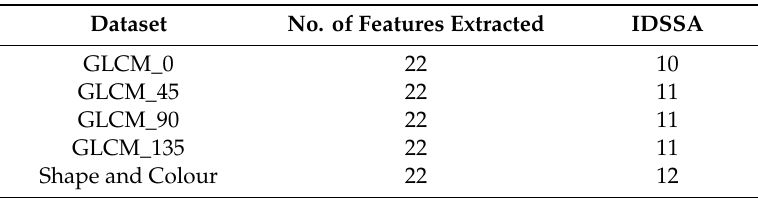
Table 3. Acquired Reducts using